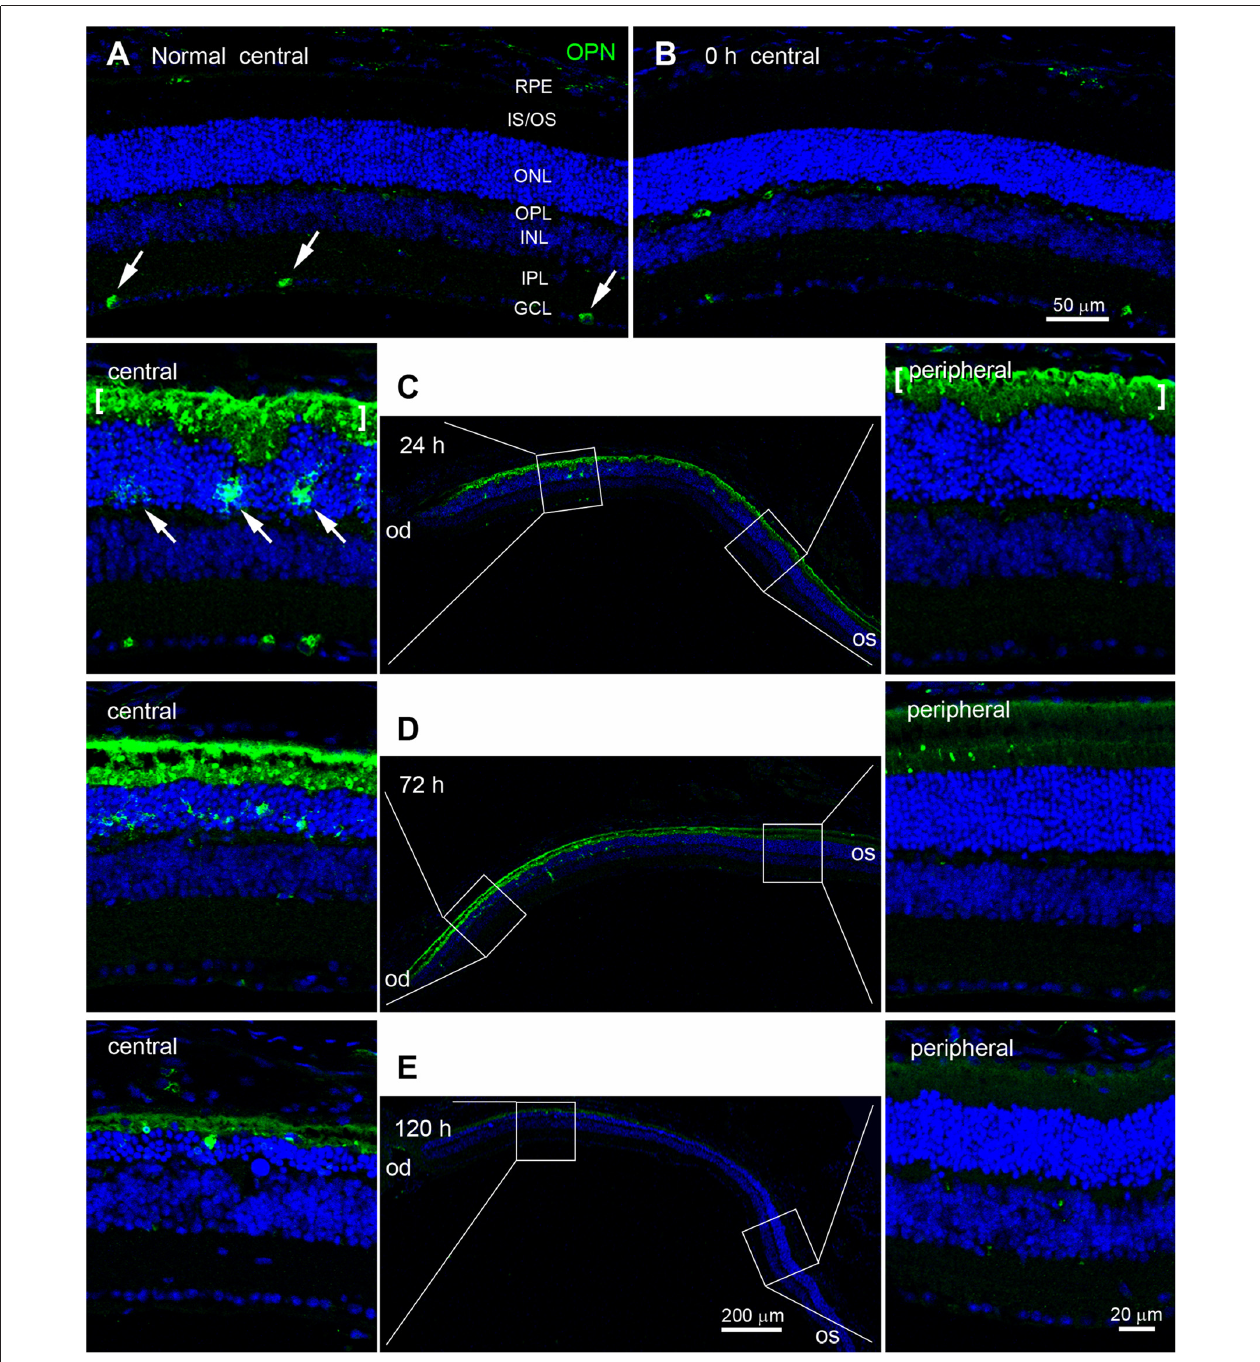
FIGURE 3 | Temporal and spatial profiles of OPN expression in blue LED-induced RD retinas. Confocal micrographs taken from vertical sections of blue LED-induced RD eyecups processed for OPN immunoreactivity. (A) A representative normal control retina. Several ganglion cells (arrows) in the GCL were weakly labeled with OPN. INL, inner nuclear layer; IPL, inner plexiform layer; IS/OS, inner segment and outer segment; ONL, outer nuclear layer; OPL, outer plexiform layer; RPE, retinal pigment epithelium. (B) A representative RD retina immediately after blue LED exposure (0 h). OPN expression was similar to that in the unexposed RD control. (C) A representative RD retina at 24 h after blue LED exposure. The central and mid-peripheral retina are magnified. Strong OPN immunoreactivity was observed in cells of the ONL (arrows) and in the subretinal space (bracket) in the central retina, but not in the peripheral retina. (D) A representative RD retina at 72 h after blue LED exposure. OPN expression was similar to that in the RD retina at 24 h after blue LED exposure; however, a relatively larger number of OPN-labeled cells were observed in the ONL of the central retina at this time point. OPN immunoreactivity in the subretinal space of the peripheral retina was negligible. (E) A representative RD retina at 120 h after blue LED exposure. OPN immunoreactivities in the ONL and subretinal space of the central retina were markedly decreased.